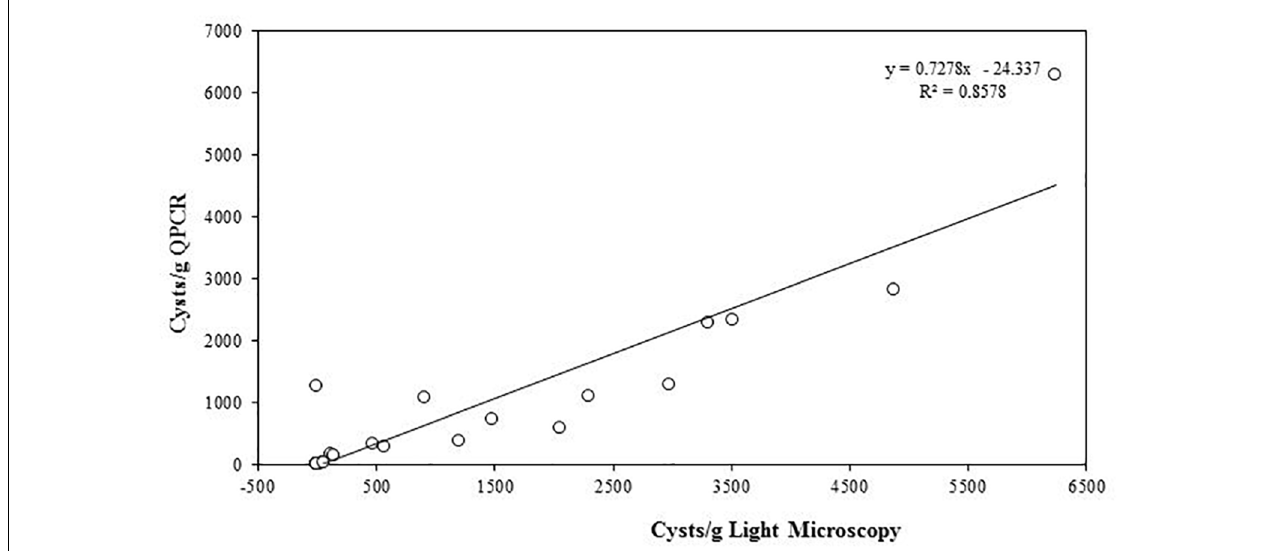
FIGURE 5 | Linear regression of A. pacificum cyst quantification from sediments with light microscopy and qPCR.